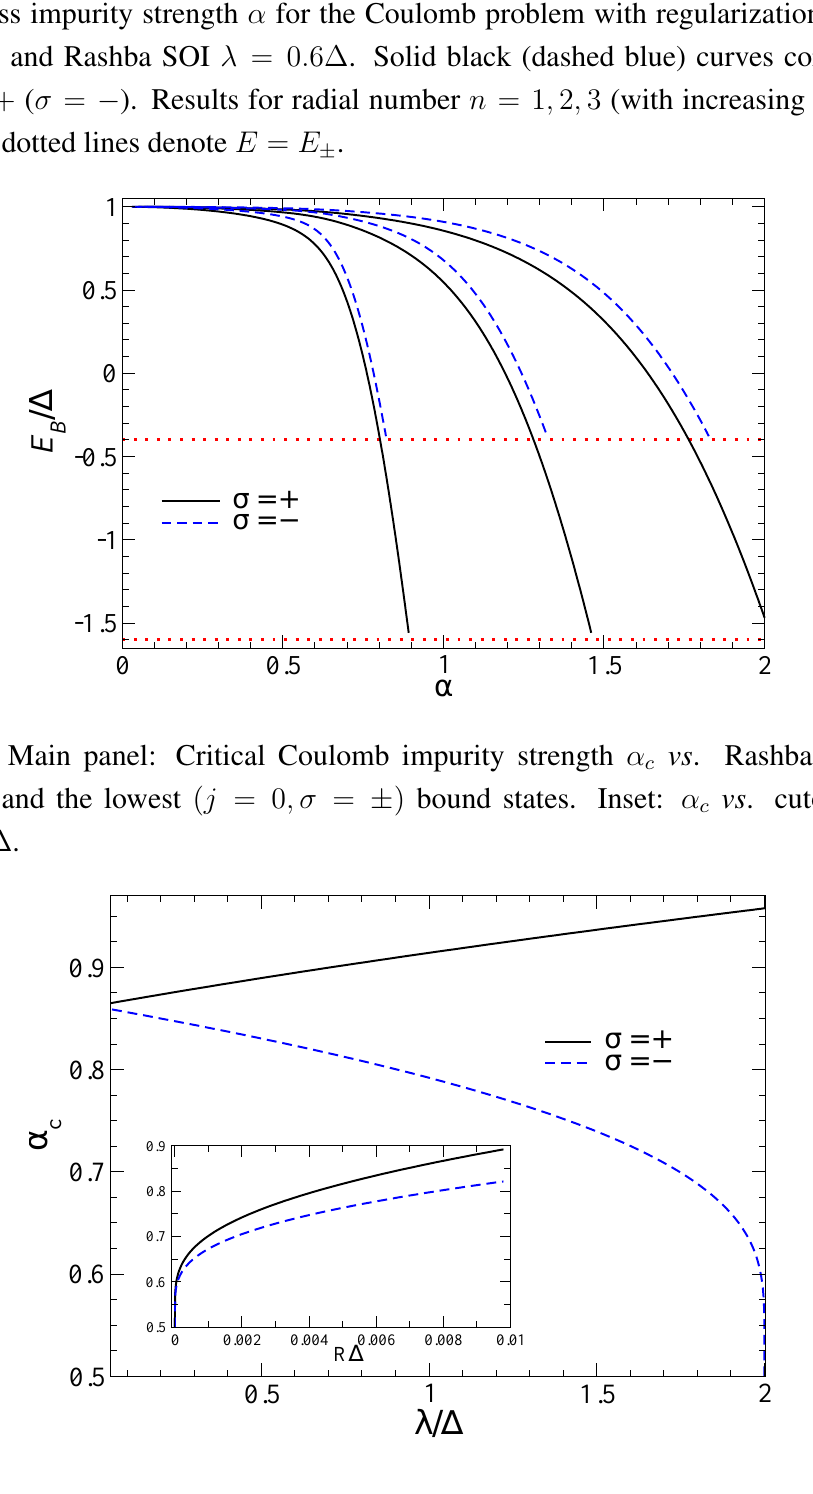
Figure 3. Bound state energies with angular momentum j = 0 ( E in units of ∆ ) vs . B dimensionless impurity strength α for the Coulomb problem with regularization parameter R ∆ = 0 . 01 and Rashba SOI λ = 0 . 6∆ . Solid black (dashed blue) curves correspond to parity σ = + ( σ = − ). Results for radial number n = 1 , 2 , 3 (with increasing energy) are shown. Red dotted lines denote E = E . ±